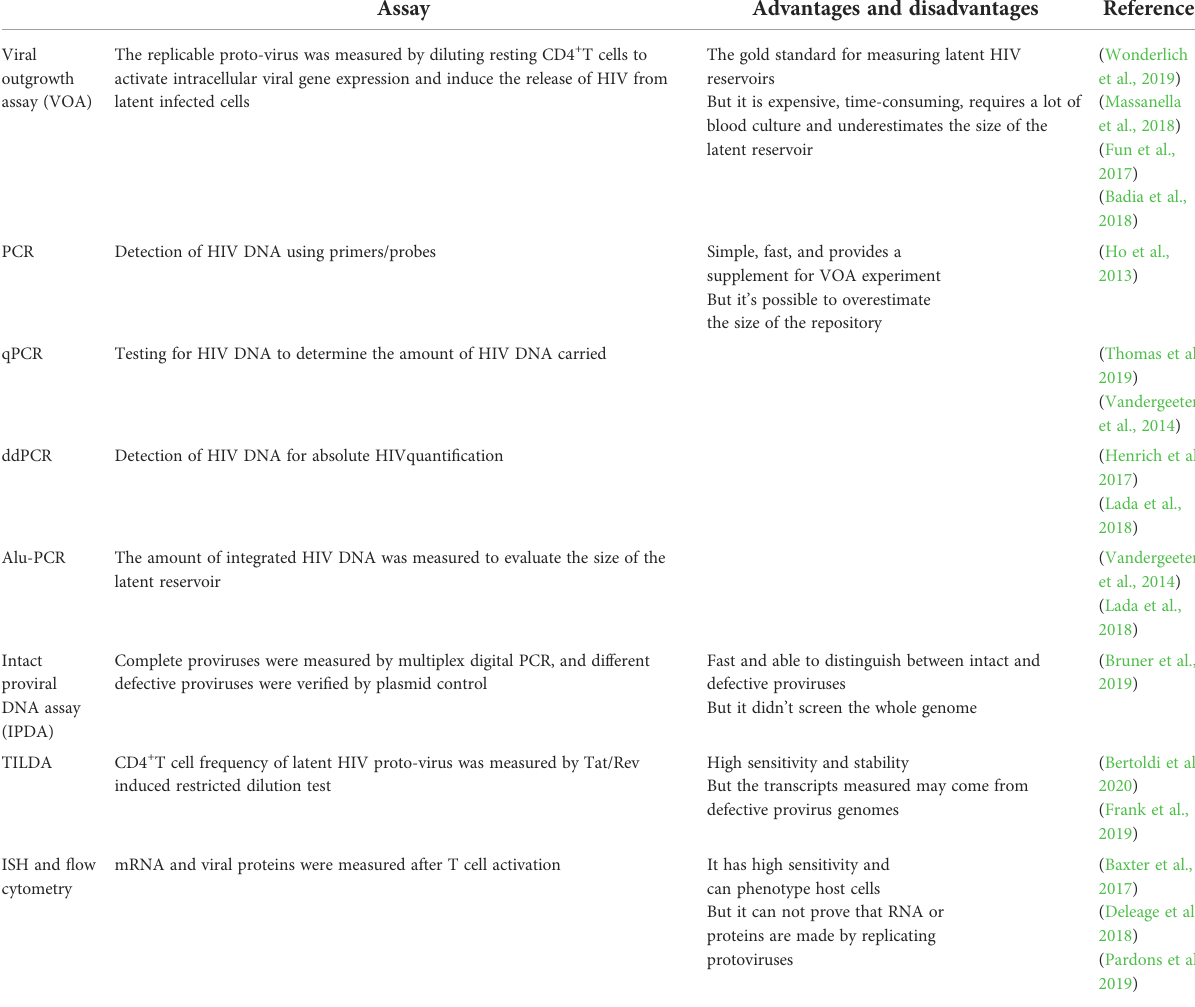
TABLE 1 The different detection methods of latent HIV reservoir.